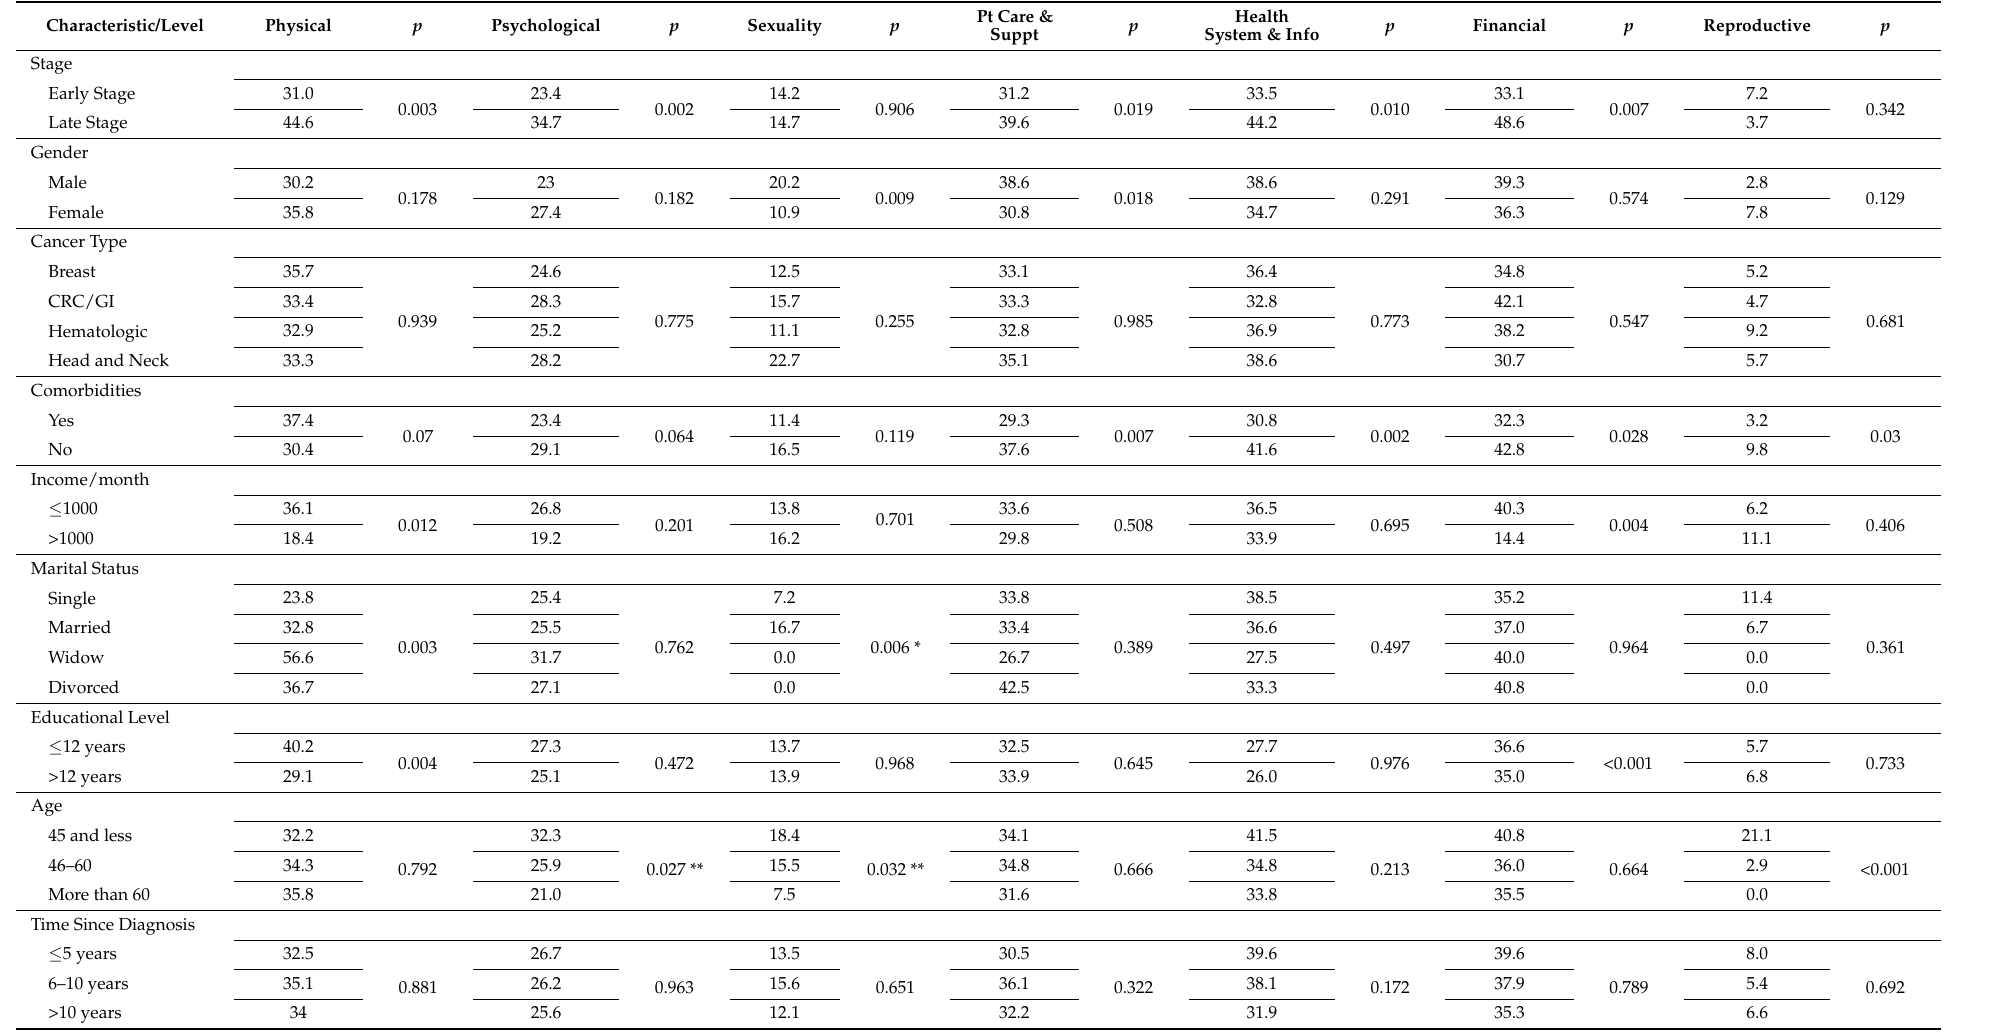
Table 4. Univariate associations between selected participant characteristics and supportive care need mean